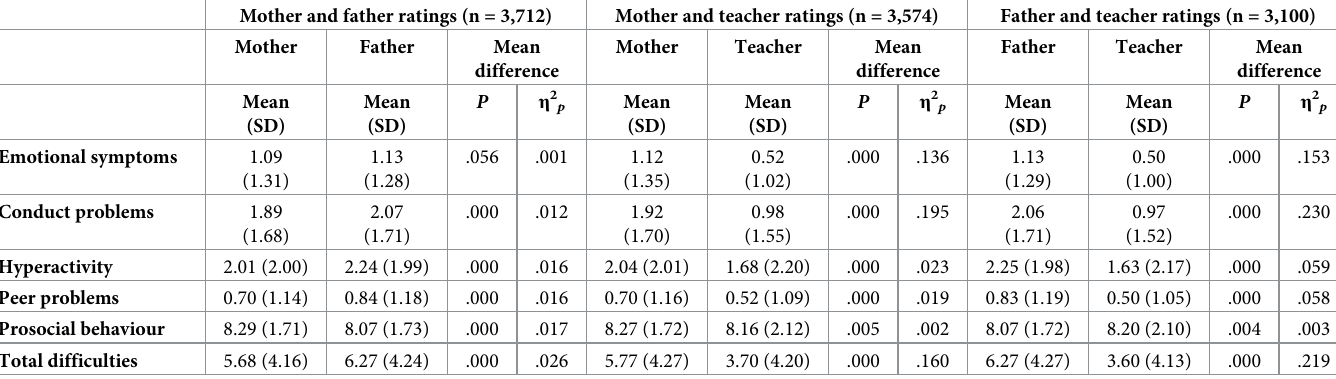
Table 3. Mean scores, standard deviations and effect sizes for mother, father and teacher ratings of 3-, 4-, and 5–year old children.